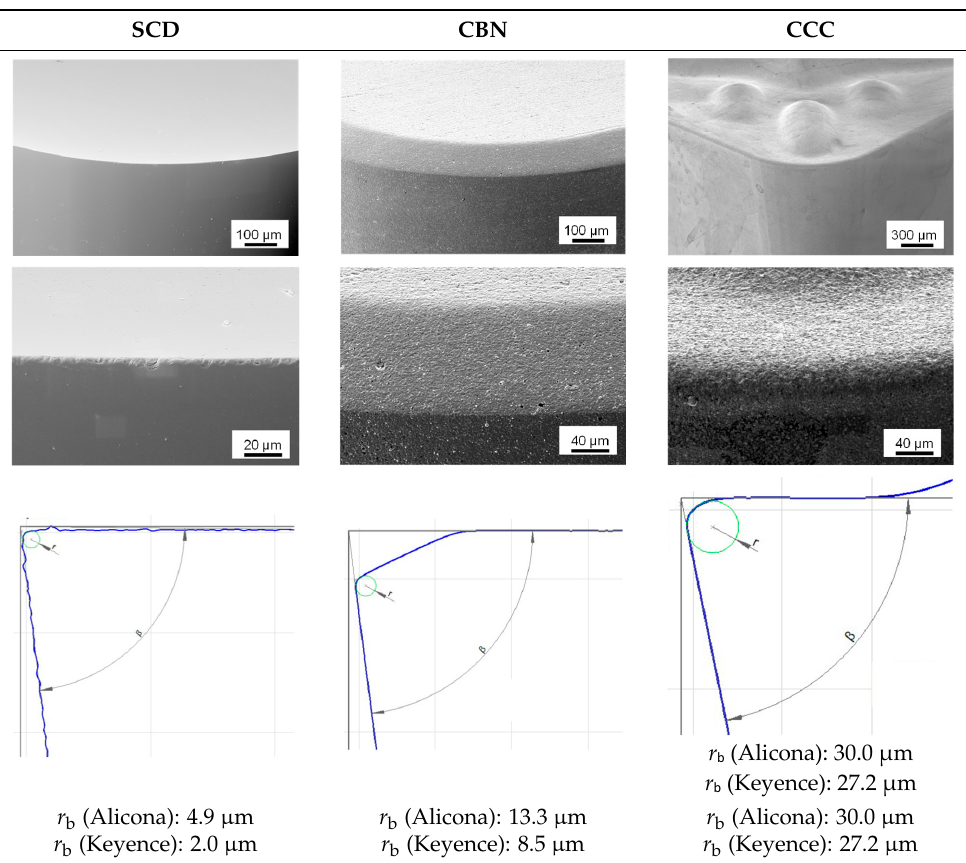
Table 1. Comparison of the used cutting tools in the unworn condition with regard to the cutting-edge radius.